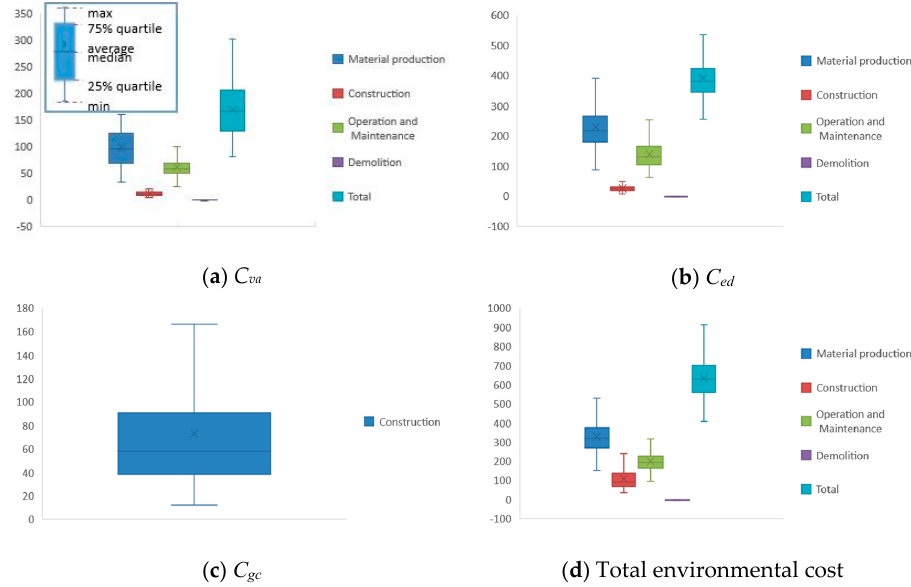
Figure 3. Environmental cost of case study building in Xiamen (unit: CNY/m 2 ). Energies 2020 , 13 , x FOR PEER REVIEW